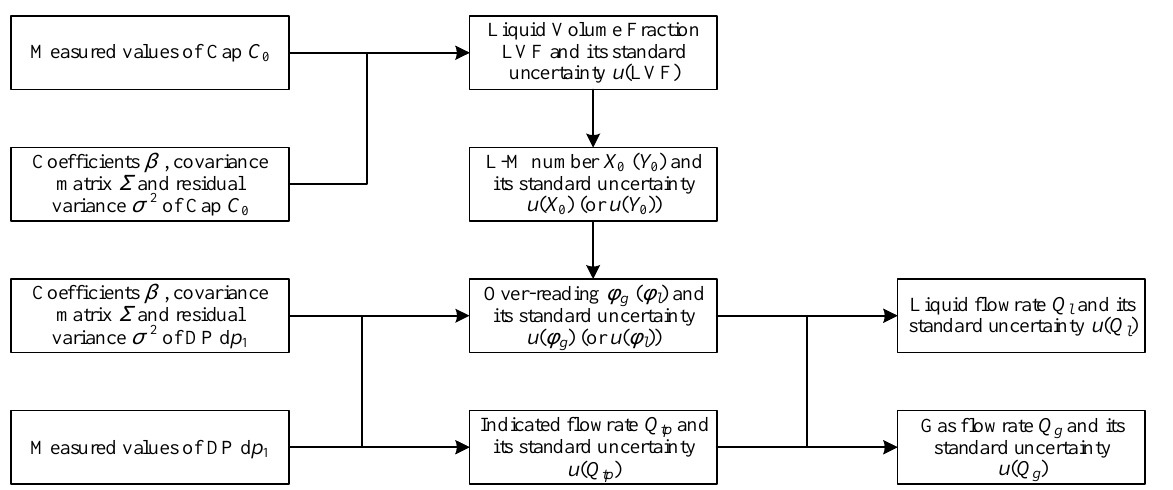
Figure 9. The calculation procedures of the differential pressure and capacitance (DP + Cap) method. After LVF 0 is obtained, it is then transformed into the L-M parameter X 0 by the